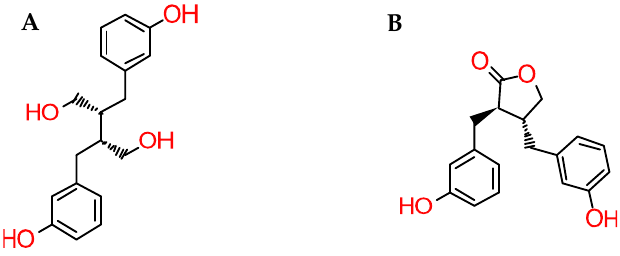
Figure 3. Chemical structure of enterodiol ( A ) and enterolactone ( B ).